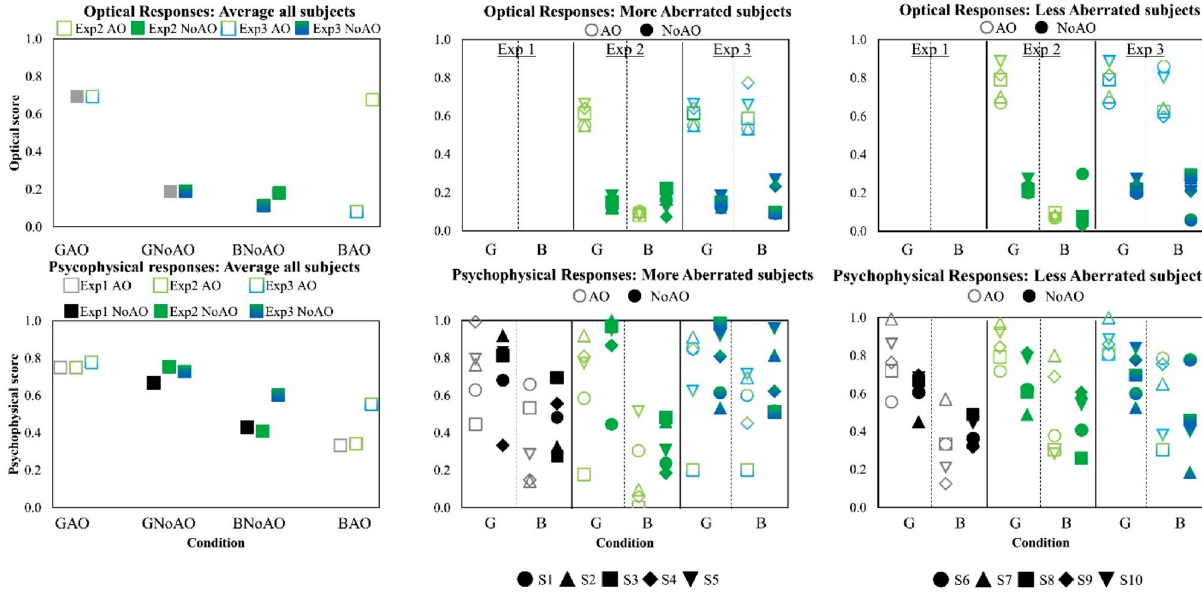
Figure 3. Results summary. Optical image quality (top panels) and Psychophysical scores (bottom panels). Left panels represent average data across all subjects. Middle panels represent data of individuals with more aberrations (S#1–S#5; VS < 0.2), and right panels data of individual less aberrations (S#6–S#10; VS > 0.2). Open bars represent results under corrected monochromatic aberrations (AO) and filled bars under natural aberrations (NoAO). Gray bars represent results for grayscale images (Exp 1), Green bars for green images (Exp 2) and graded green–blue bars for green and blue images (Exp 3). In the middle and right panels, open symbols stand for results under corrected monochromatic aberrations (AO) and closed symbols for results under natural aberrations (NoAO). Black symbols correspond to Exp 1, green symbols to Exp 2 and green and blue symbols to Exp